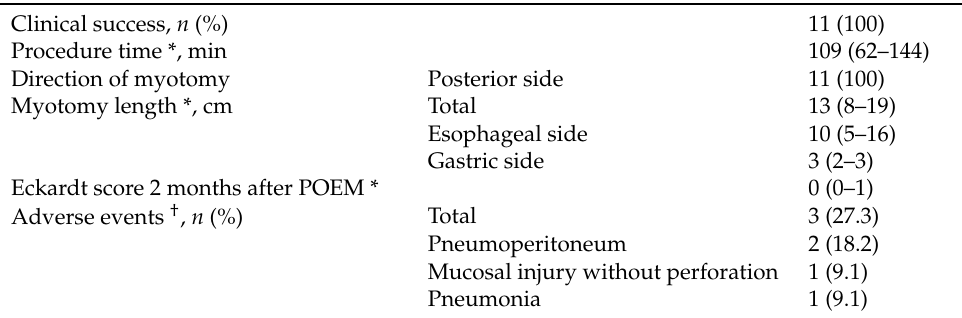
Table 2. Clinical outcomes of POEM.